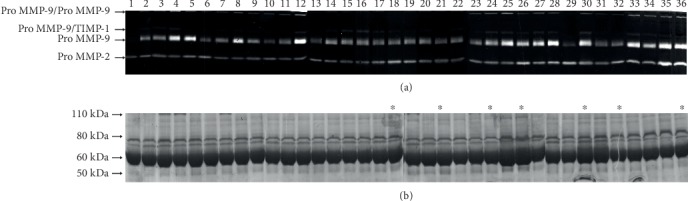
Pro-MMP-2 and Pro-MMP-9 activity levels evaluated by gelatin zymography. (a) Prototype of gelatin zymography of 36 randomly selected serum samples used. (b) SDS-PAGE electrophoresis of the same serum samples of (a) stained with Coomassie Blue. LLIs are indicated in (b) with asterisks.